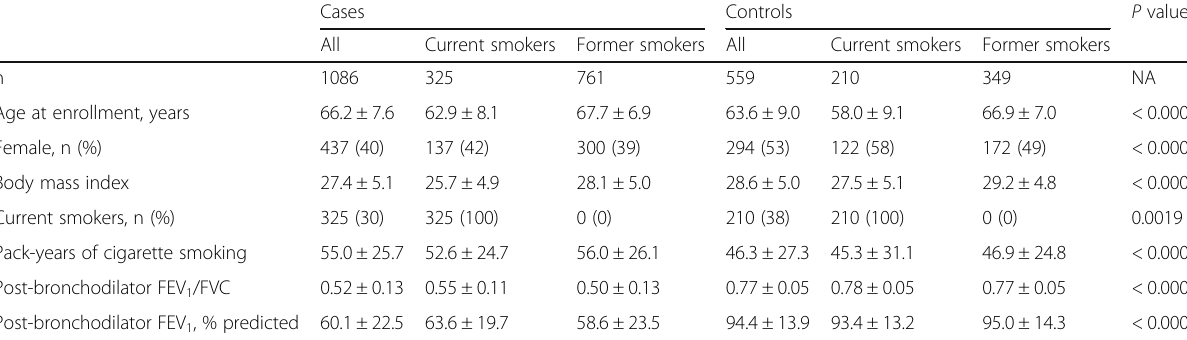
Table 1 Demographics (Mean ± SD) of Non-Hispanic White Subjects in SPIROMICS Cases Controls